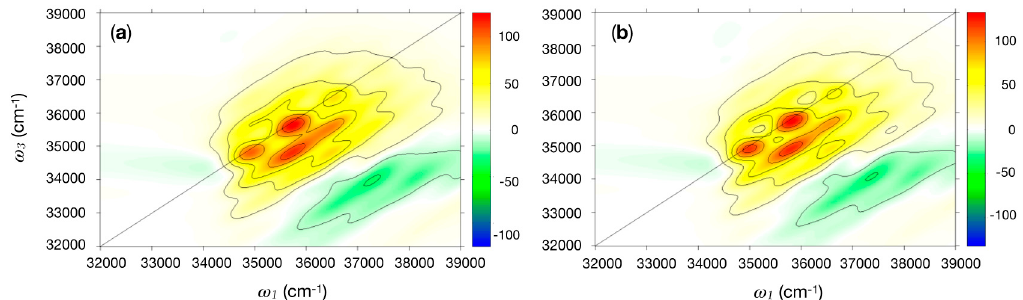
Figure 2. Two-dimensional electronic spectroscopy in the UV region (2DUV) spectrum in the near UV for (a ) cPY_300; ( b ) cYY_300_60. Plots of ω 3 (cm − 1 ) versus ω 1 (cm − 1 ) for the real part of the signal. Polarisation of the four pulses is xxxx. The intensity has been renormalised to the number of Tyr (i.e., maps in ( b ) has been divided by 2).